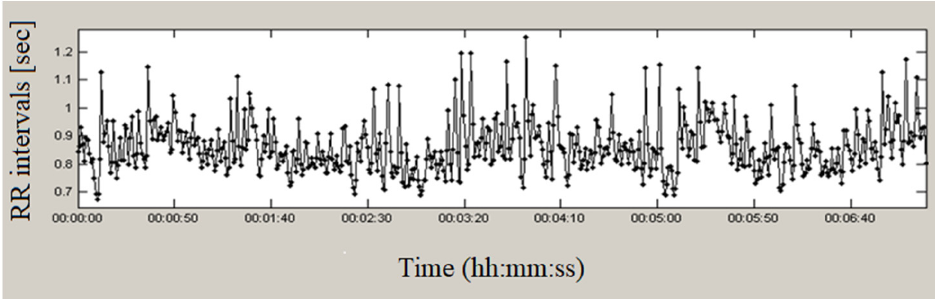
Figure 3. Holter record (7 min) of a healthy individual.